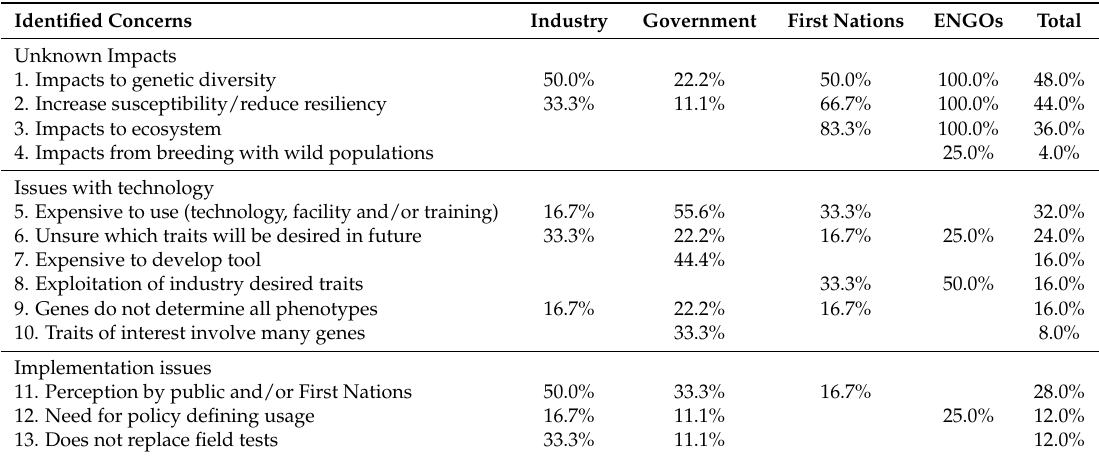
Table 6. Identified concerns of MAS, represented in relative proportions by groups and by the total sample population, calculated using relative